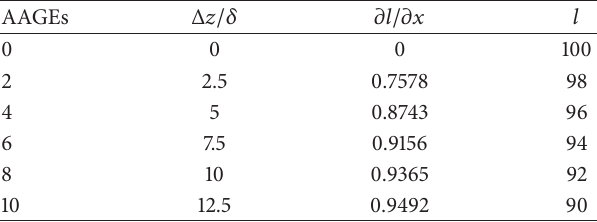
Table 3: Relationship between Δ𝑧/𝛿 , 𝜕𝑙/𝜕𝑥 , and 𝑙 .